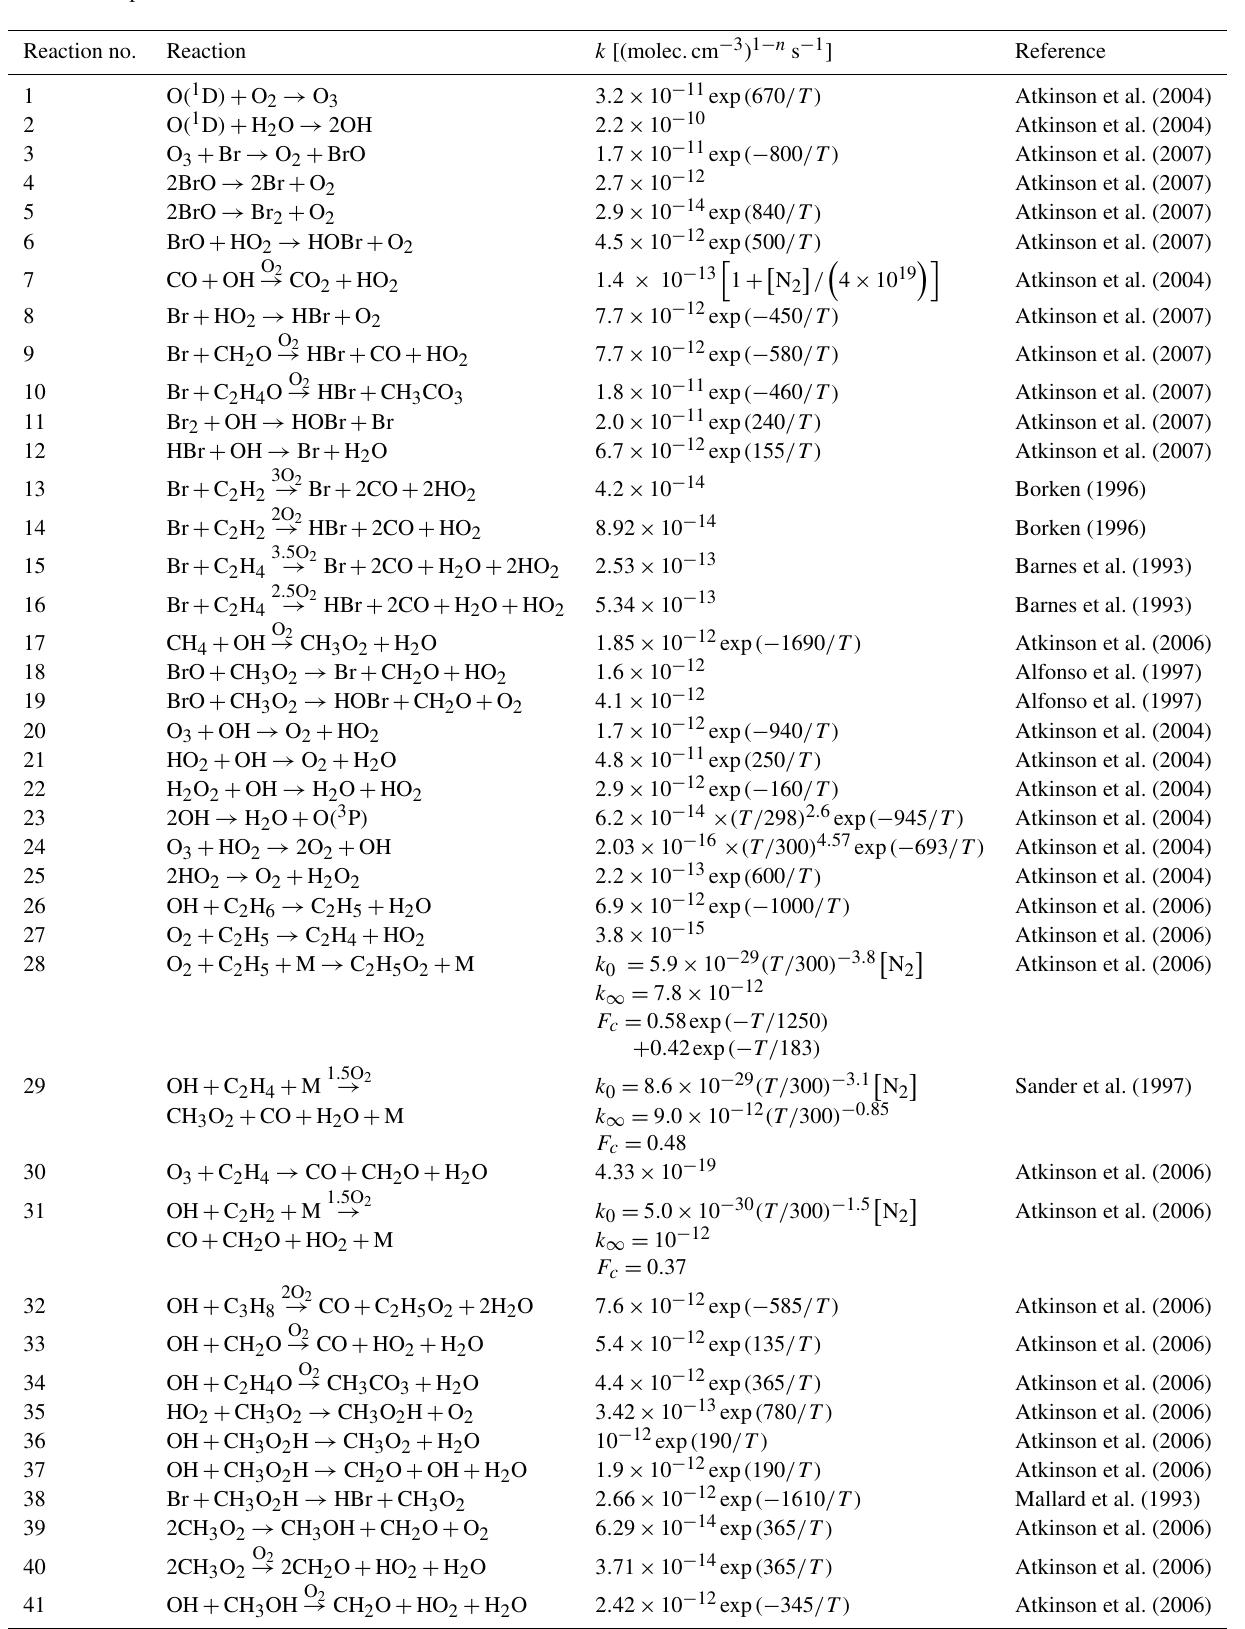
Table A1. Gas-phase reactions. Reaction